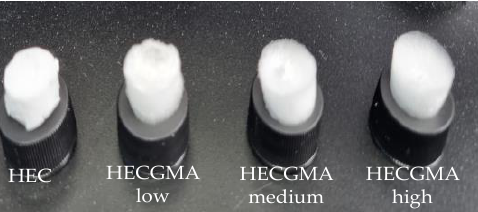
Chitosan low Figure 6. Physical appearance of lyophilised wafers based on HEC and HECGMA derivatives. Figure 6. Physical appearance of lyophilised wafers based on HEC and HECGMA